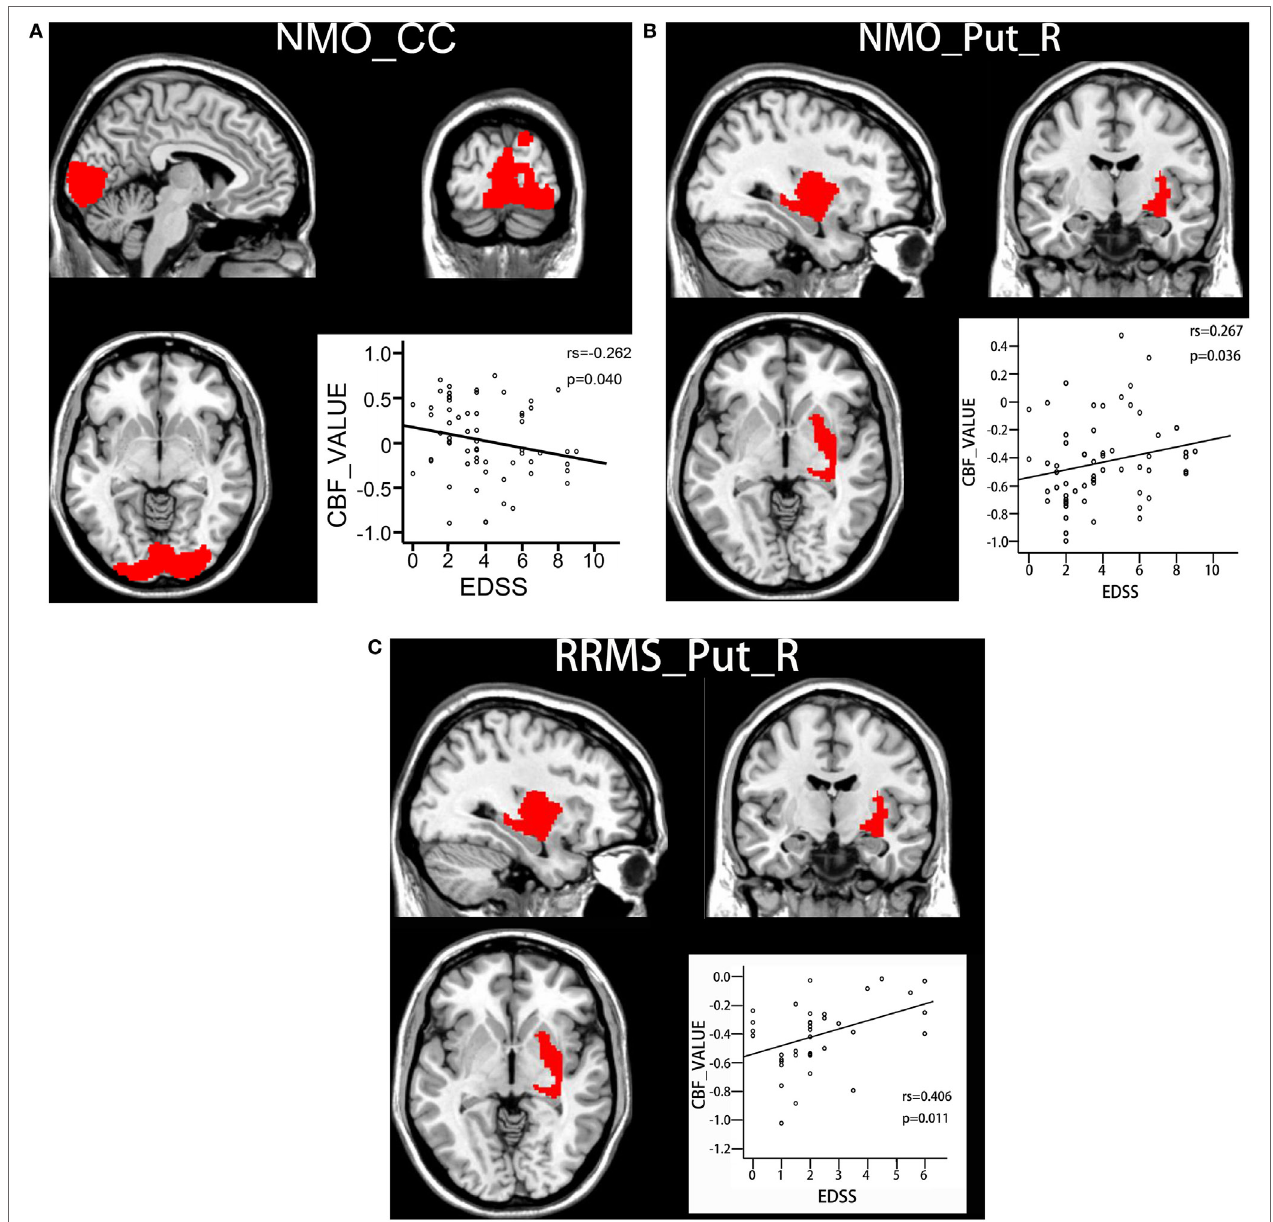
FigUre 3 | Correlations between CBF values and clinical disability in both patient groups. (a) Spearman correlations between CBF values in the bilateral calcarine cortex and EDSS scores in NMO patients. (B) Spearman correlations between CBF values in the right putamen and EDSS scores in NMO patients. (c) Spearman correlations between CBF values in the right putamen and EDSS scores in RRMS patients. Abbreviations: CBF, cerebral blood flow; CC, calcarine cortex; EDSS: Expanded Disability Status Scale; RRMS, relapsing-remitting multiple sclerosis; NMO, neuromyelitis optica; Put, putamen; R,